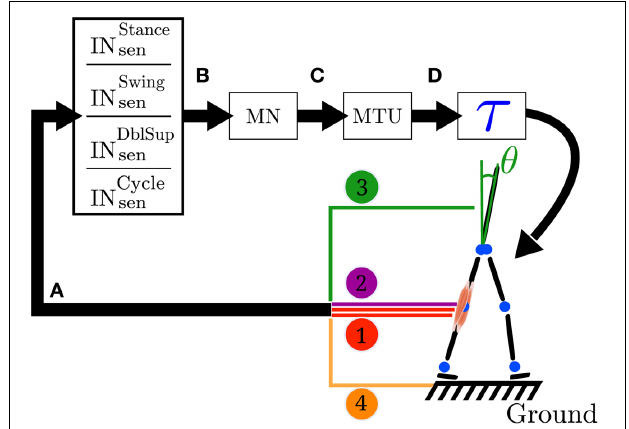
FIGURE 1 | Closed loop information flow of the FBL model. (A) Sensors signals stimulate (see Equation 1) a set of sensory interneurons (IN sen ). The sensors signals are represented by the colored line; 1 represents the muscle sensors, 2 represents the joint overextension/flexion prevention sensors, 3 represents the stability sensor generating a signal to maintain the trunk upright and 4 represents the ground sensors. There are four different types of sensory interneurons: IN stance sen which are active only during stance, IN swing sen only during swing, IN dblsup sen , only during the double support phase and IN cycle sen during the whole cycle. (B) Each IN sen is connected to a unique motoneuron (MN). However a given MN receives inputs from several IN sen . Connections between IN sen and MN follow Equation 2. (C) In turn, each MN stimulates its corresponding muscle tendon unit (MTU). (D) Each MTU contributes to a torque ( τ ) on one or two joints, depending on whether it models a uni- or bi-articular muscle. Finally, the action of all the muscles on the body generates a movement, which induces a change in the sensors state and thereby closes the loop. Note that in the original model the link between sensors states and muscles activities is direct (i.e., no intermediary stage), while here the sensors to muscles mapping is separated in three more biologically relevant stages: sensory interneurons (IN sen ), motoneurons (MN) and muscle tendon units (MTU). Note that both the original and the FBL model are computationally